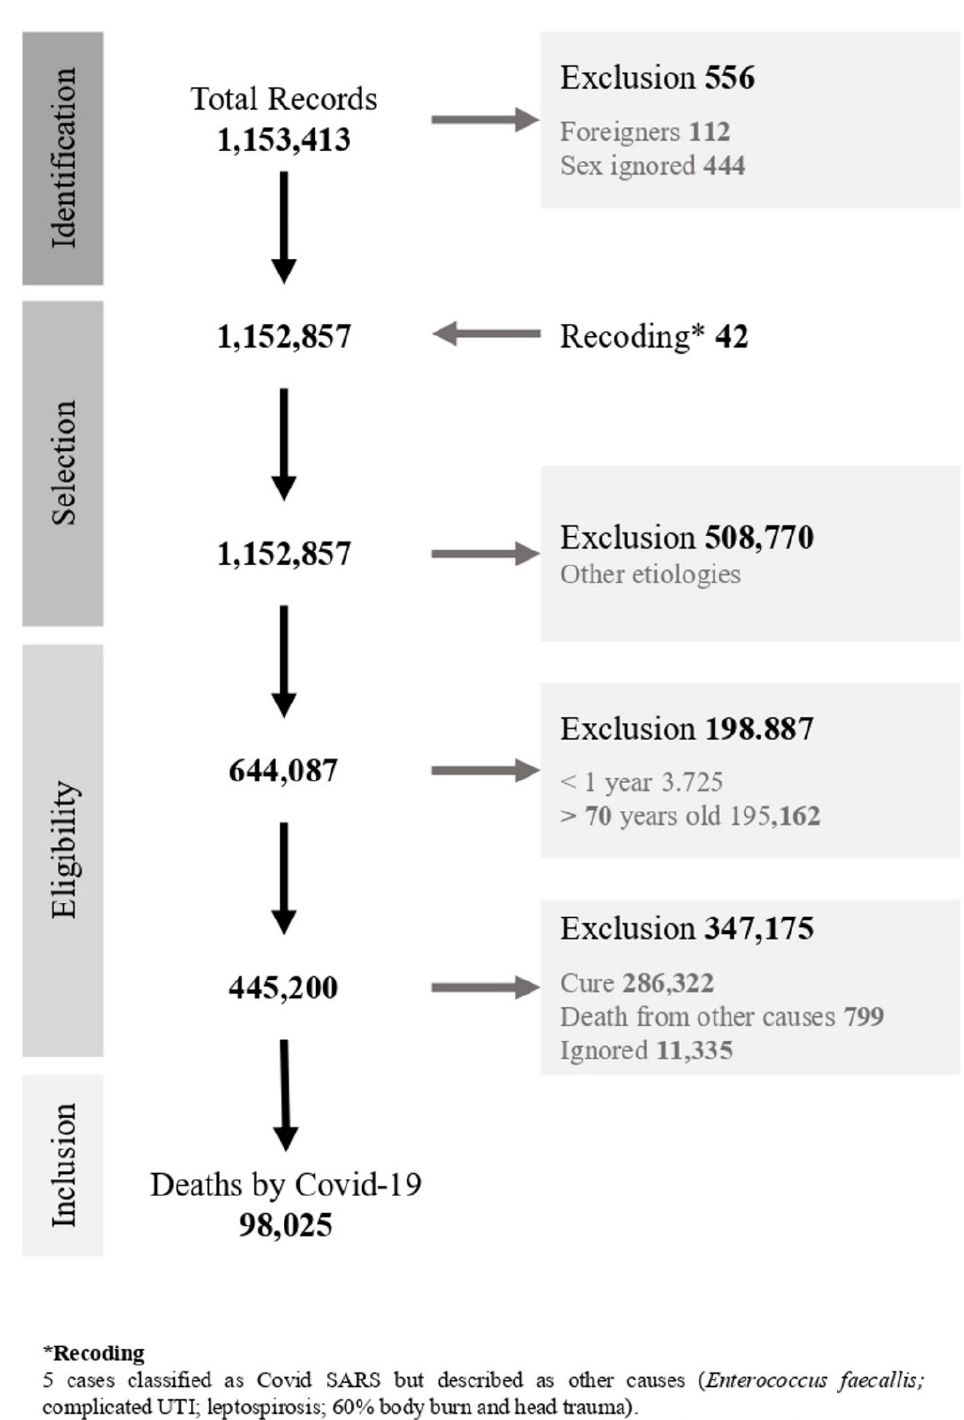
Figure A1. Adequacy and adjustment of the SIVEP-Gripe database and selection of death records for COVID-19 in Brazil